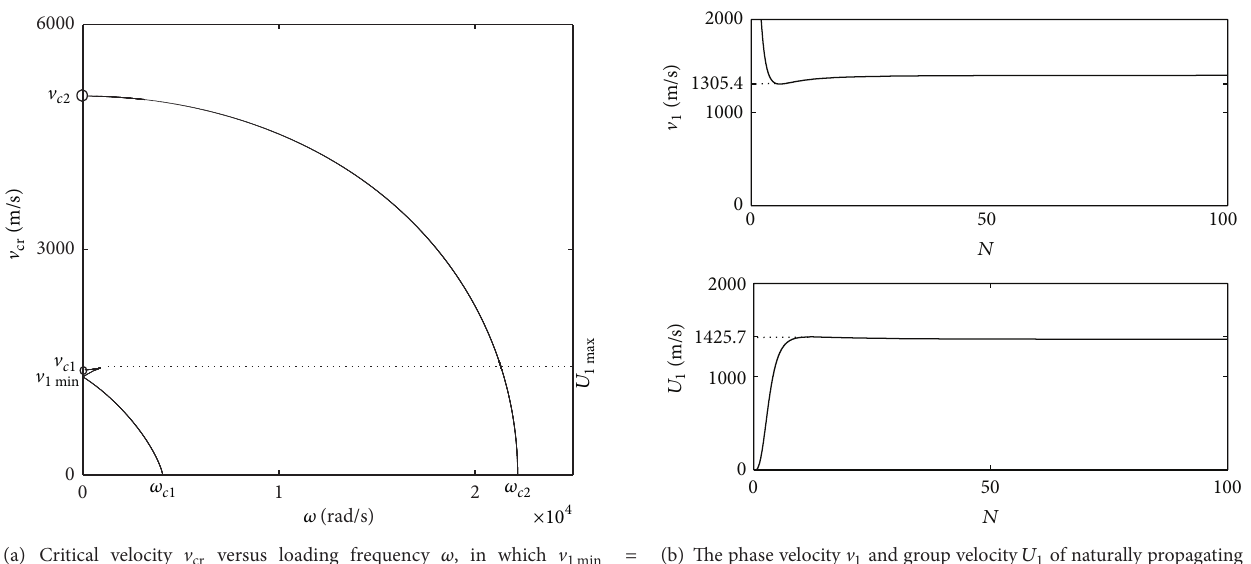
(a) Critical velocity V cr versus loading frequency 𝜔 , in which V 1 min = (b) The phase velocity V 1 and group velocity 𝑈 1 of naturally propagating 1305.4 m / s < V 𝑐1 , 𝑈 1 max = 1425.7 m / s > V 𝑐1 , as shown in Figure 5(b) waves versus wave number 𝑁 , V 1 min = 1305.4 m / s, 𝑈 1 max = 1425.7 m / s Figure 5: Critical velocity V varies with loading frequency 𝜔 for 𝑘 = 1 × 10 9 N/m 2 . cr